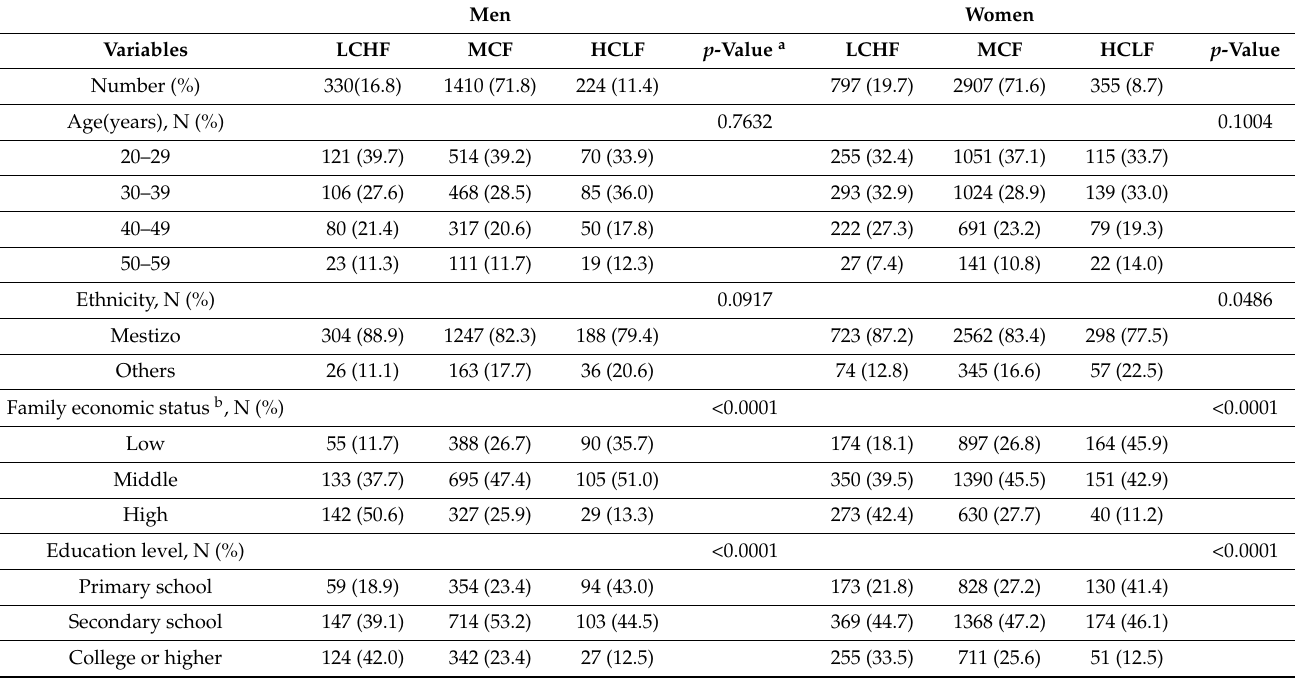
Table 1. Demographic, health-related lifestyle, and physical environmental characteristics of study participants by carbohy- drate and fat